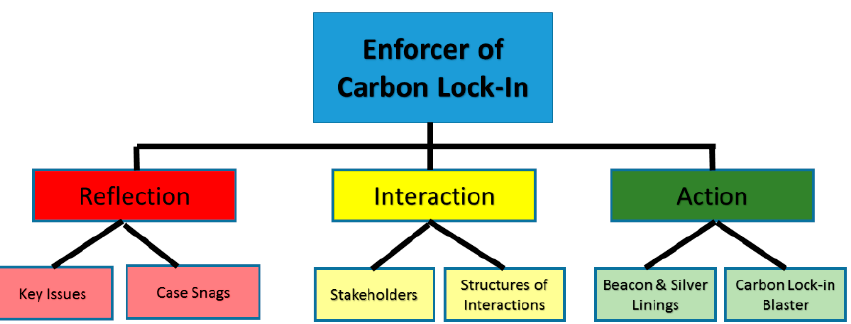
Figure 4. The learning activation framework: Mexico’s carbon lock-in. Source: Authors (CC by